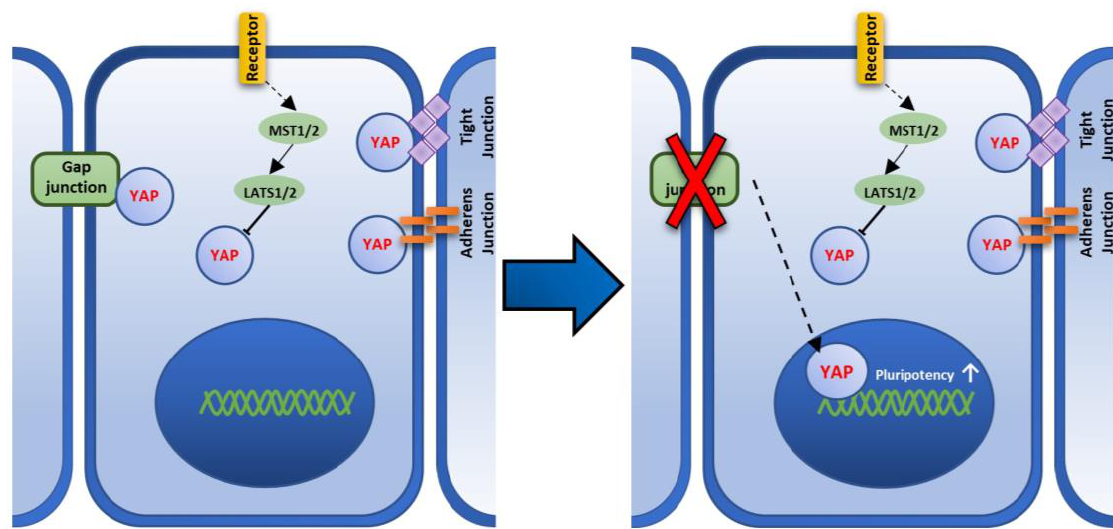
Figure 8. A figure showing the proposed Cx43-YAP mediated pathway that regulates pluripotency in Muse cells. Hippo pathway that is mediated by large tumor suppressor kinase (LATS) and the serine/threonine protein kinase (MST), phosphorylates Yes-associated protein (YAP), and inhibits its transcriptional function by anchoring it to the cytoplasm [30]. YAP is also anchored to the cell membrane through binding to the gap junction, adherens junction, and tight junction [30]. Upon GJ disruption, YAP is translocated to the nucleus leading to the up-regulation of pluripotency factors. qPCR analysis of 18 α -GA-, TPA- and DDT-treated-Muse cells showed that the ex- pression levels of NANOG , OCT3/4 , and SOX2 were increased—or showed a tendency of up-regulation—in all three kinds of inhibitors, when compared to the untreated-Muse influence on pluripotency up-regulation was different from each other; DDT had the